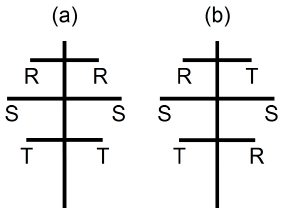
Figure 6. Two common phase arrangements for a standard 220 kV or 380 kV tower, for phases designated R, S, and T. ( a ) plane symmetry; ( b ) central symmetry. Four other, intermediate configurations are also possible, but not shown here.